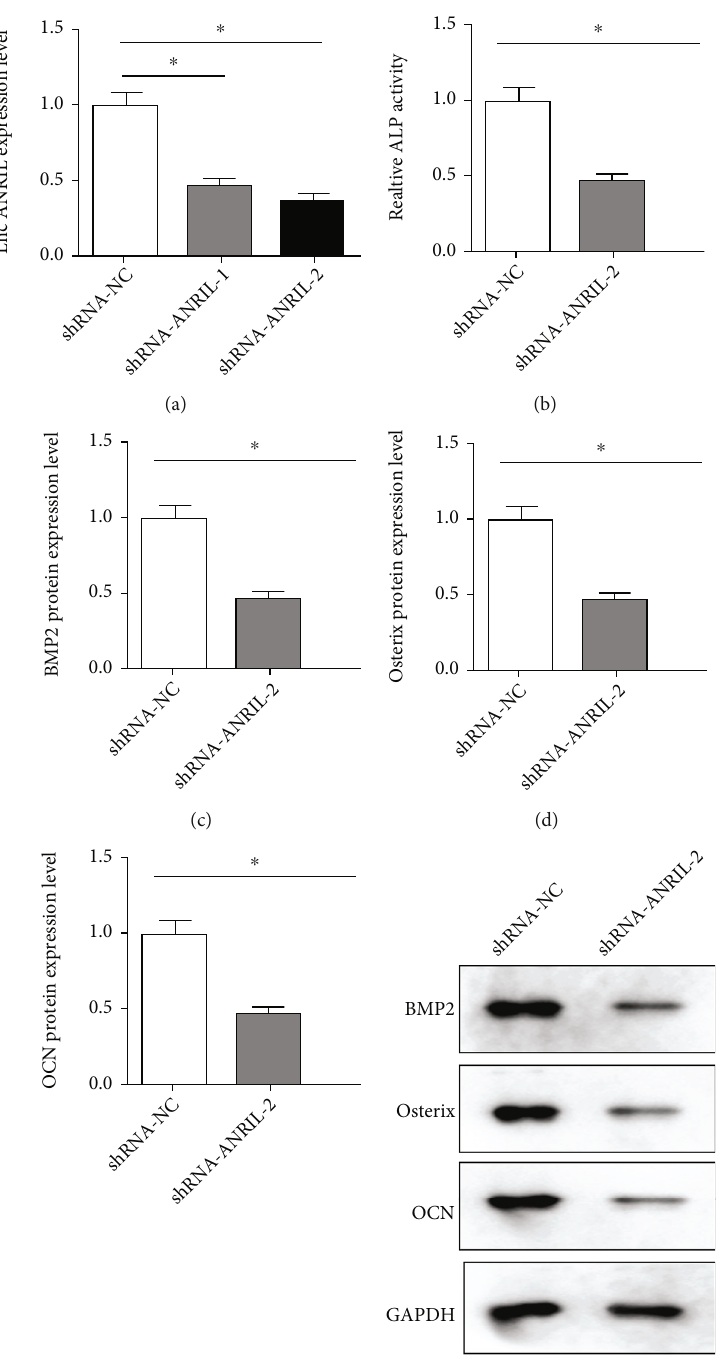
Figure 3: (a) The transfection e ffi ciency was measured by qPCR with PDLC transfection of shRNA-ANRIL-1, shRNA-ANRIL-2, and shRNA-NC. (b) ALP activity was detected posttransfection. The protein levels of (c) BMP2, (d) Osterix, and (e) OCN were quanti fi ed. (f) The proteins were detected by Western blot posttransfection. GAPDH was used as an internal control. ∗ P < 0 : 05